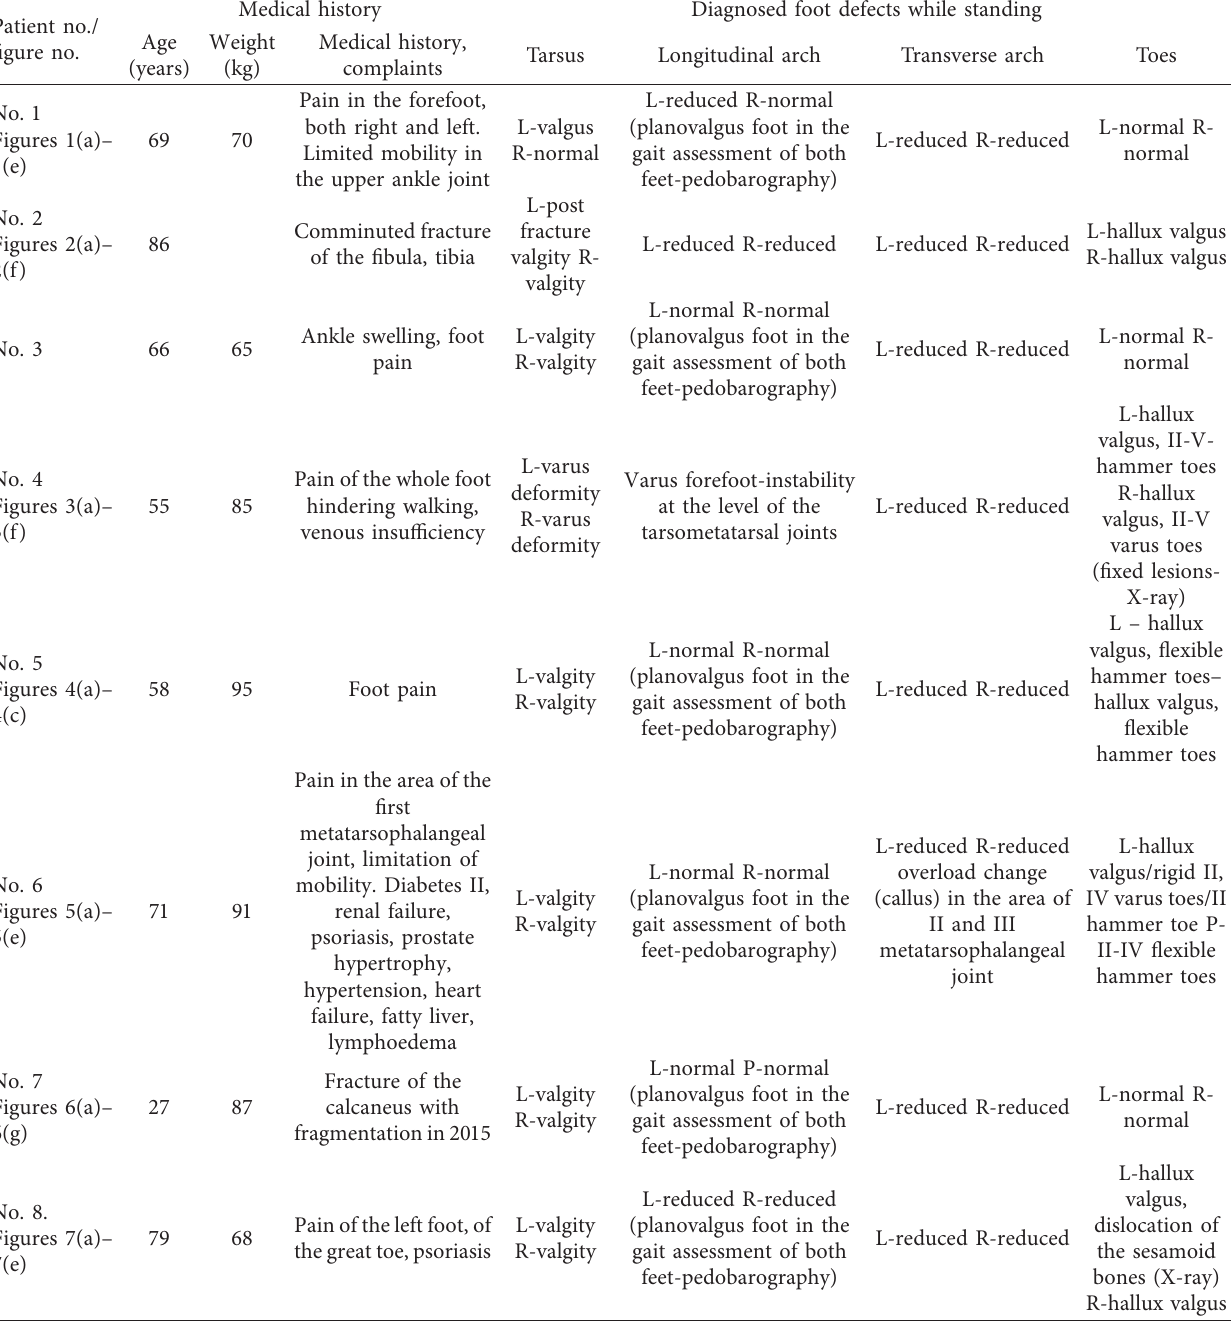
Table 1: Summary of general information, defects, and ailments of the feet of patients included in the study, together with an assessment of functionality in individual areas of the foot (foot, longitudinal arch, transverse arch, and toes). Patient